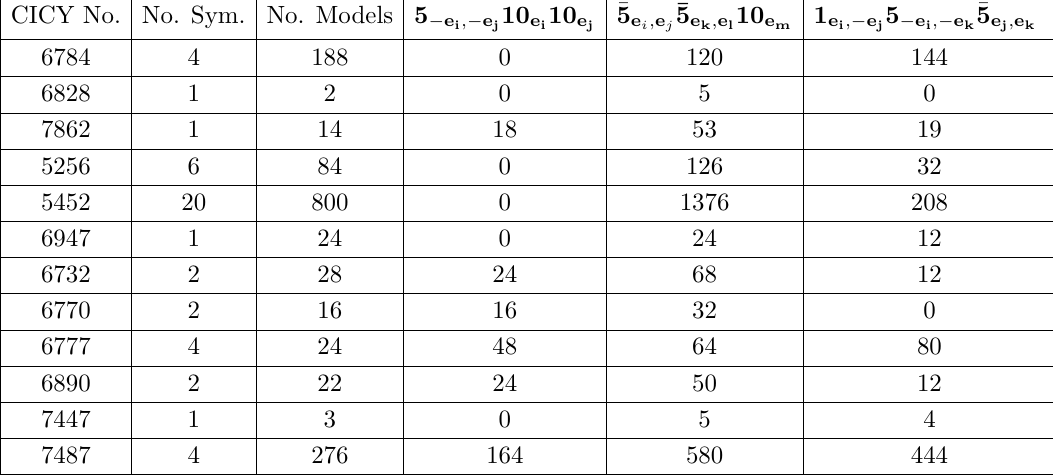
Table 4 . The number of Yukawa couplings of various types that are permitted by the gauge symmetries of the set of Line Bundle Standard Models being considered [19, 20, 105]. The (cid:12)rst column gives the CICY identi(cid:12)cation number of the manifold on which the models are based, according to the standard list [75, 104]. The second column details how many symmetries are being considered, and thus the number of downstairs manifolds that each row corresponds to. ‘No. Models’ gives the number of models with at least one Yukawa coupling that would be consistent with gauge invariance in the data set. The remaining three columns give the number of each type of such couplings that appear in this set of